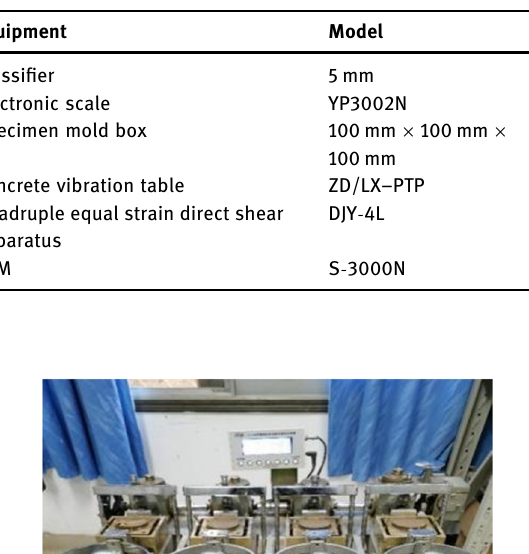
Table 4: Main test instruments and